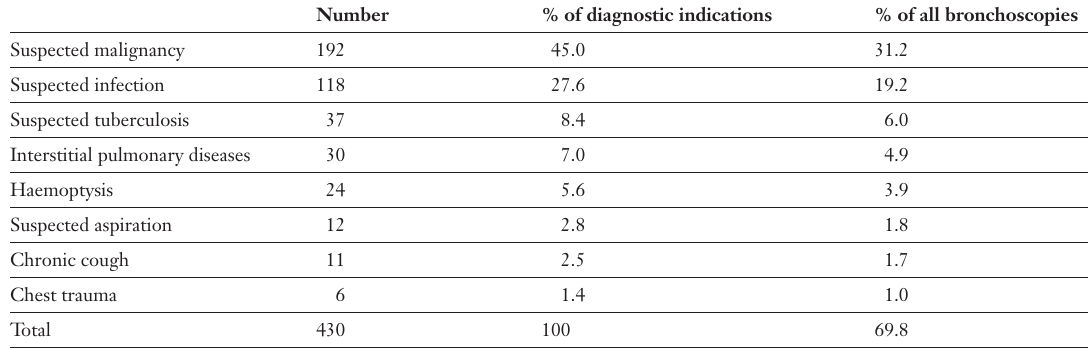
Figure 1 Diagnostic yield of flexible bron- choscopy (FFB) in 430